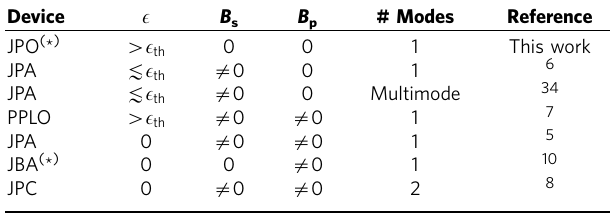
Table 1 | Overview of different modes of operation for the various Josephson amplification and detection schemes.